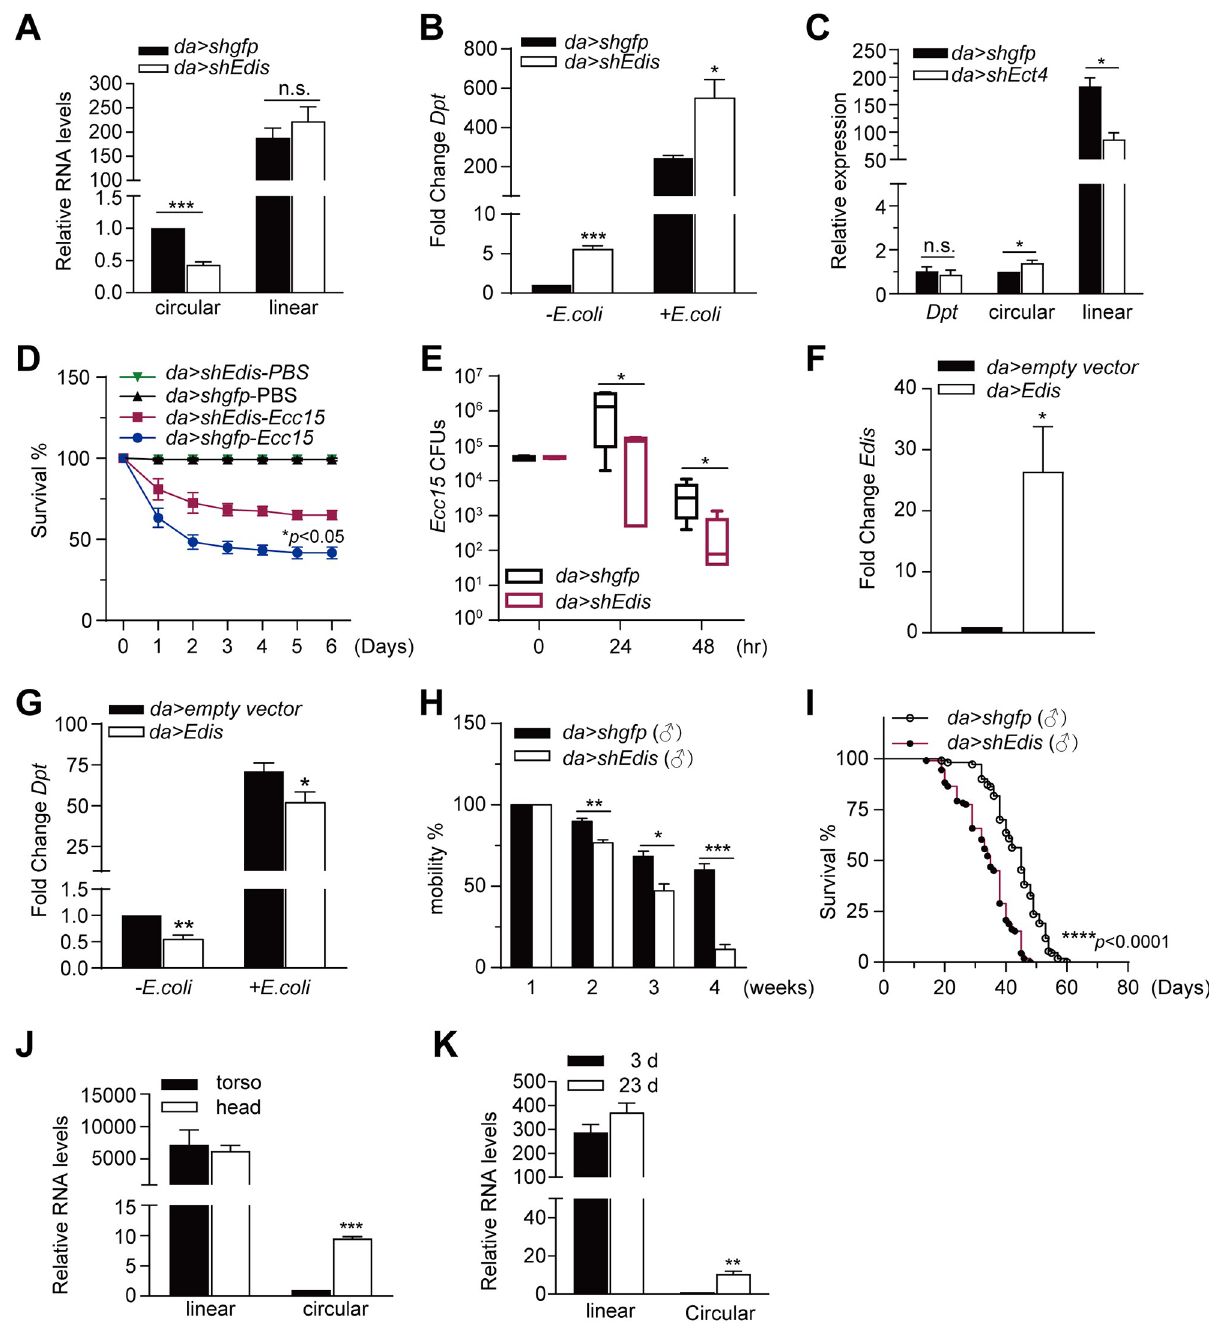
Fig 3. Edis regulates innate immunity in vivo . ( A-B ) Flies carrying the ubiquitously expressed daughterless-Gal4 driver and a temperature-sensitive Gal80 were crossed to UAS-shEdis or control shGFP flies. Fly crosses were kept at 18˚C. Adult progeny were shifted to 29˚C for 5 days to allow for shRNA transgene expression. Flies were either left untreated or infected by E . coli , total RNAs were extracted 6-h post-infection and levels of linear Ect4 and circular Edis RNA ( A ) and Dpt ( B ) were measured (student t test, n � 3, � p < 0.05; ��� p < 0.001; ns, non-significant). ( C ) The UAS-shEct4 was employed to knockdown the linear Ect4 RNA in vivo using a similar strategy as in A . Levels of Ect4 , Edis and Dpt were measured (student t test, n = 3, �� p < 0.01; ns, non-significant). ( D ) Edis knockdown and control flies in multiple groups (20–25 flies per group) were injected with a concentrated culture of Erwinia carotovora carotovora 15 ( Ecc15 ) or PBS (control). Fly survival was recorded daily and plotted (log rank test, n � 3, � p < 0.05). ( E ) At various time points post Ecc15 infection, groups of 4 flies were homogenized in sterile PBS. Fly homogenates were diluted and plated onto Ampicillin-LB plates, and the resultant colonies were counted. Shown are c olony-forming u nits ( CFU s) per fly (student t test, n � 4, � p < 0.05). ( F-G ) The UAS-Edis transgenic line was employed to overexpress Edis in vivo using a similar strategy as in A . The UAS-laccase 2 empty vector transgene was included in the crossing